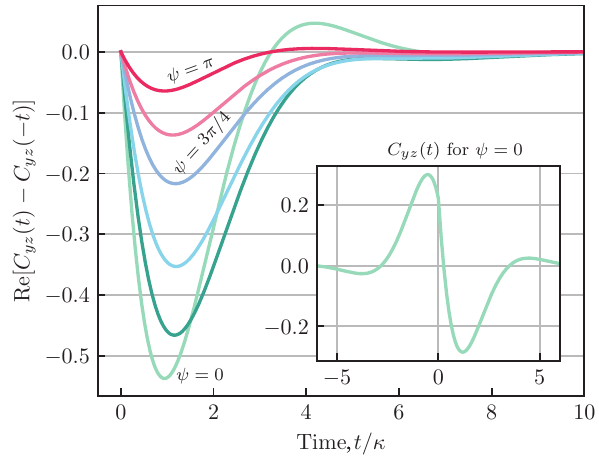
FIG. 9. The Rabi-driven qubit violates conventional quantum detailed balance. Inset: the correlation function C yz ( t ) is shown as a function of time for TRS ψ = 0. Although time symmetry is not explicitly ruled out for ψ = 0, the lack of time symmetry is clear. We show only the connected part, which decays to zero for | t | (cid:13) κ . Main plot: the time asymmetry of the symmetrized cor- relation function Re[ C yz ( t ) − C yz ( − t ) ] as a function of time t /κ for different permissible TRS. The correlation function is com- plex in general for ψ (cid:11)= 0, π ; however, the time asymmetry is manifest even in the real part alone. The values of ψ in order from top to bottom are π , 5 π/ 6, 3 π/ 4, 5 π/ 8, π/ 2, and 0. All functions are computed for Rabi drive strength b =